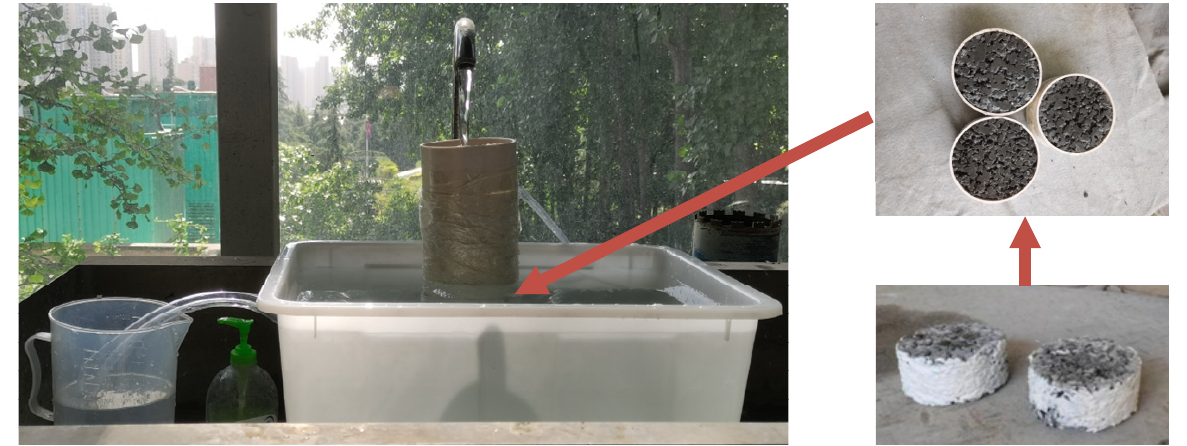
Figure 8. The testing of permeability coefficient.